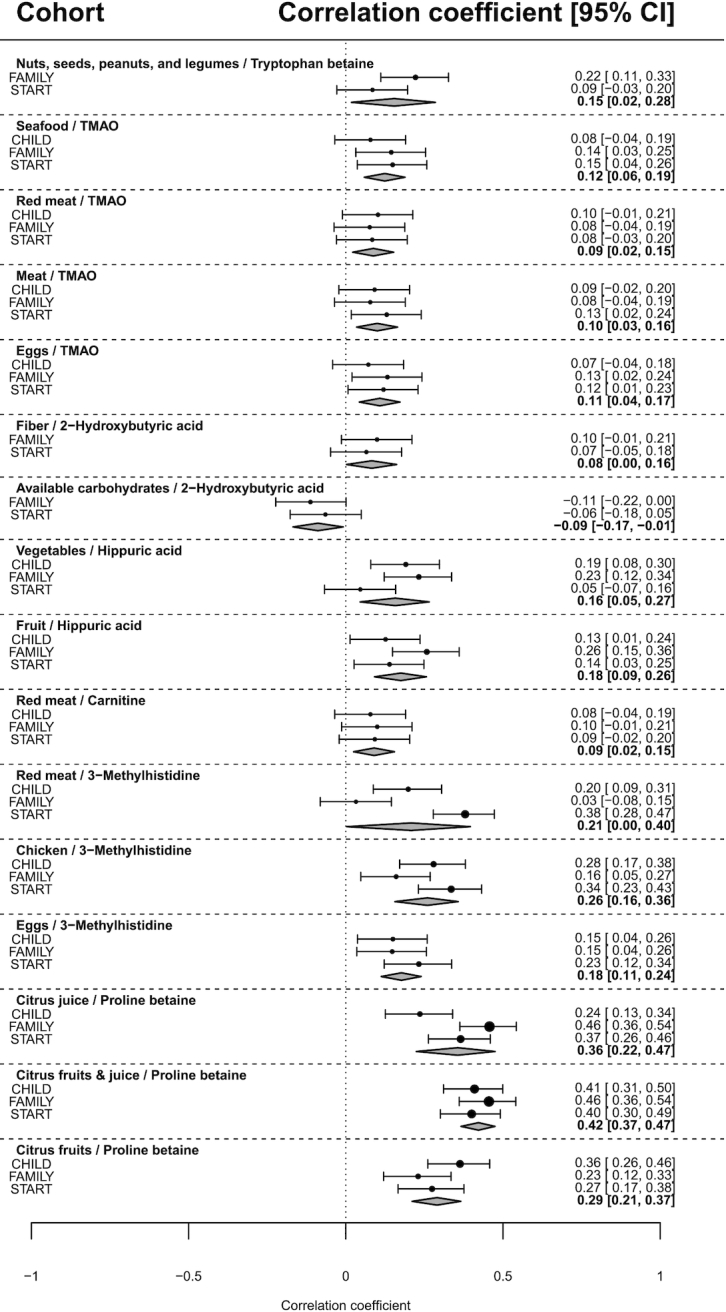
Random effects meta-analyses of metabolite-to-food groups correlations by cohort. Shaded diamonds at the bottom of each meta-analysis shows the pooled point estimate and the left and right vertices are the lower and upport 95% confidence limits. CHILD, Canadian Healthy Infant Longitudinal Development study; FAMILY, Family Atherosclerosis Monitoring In earLY life study; START, SouTh Asian biRth cohorT study; TMAO, trimethylamine N-oxide.